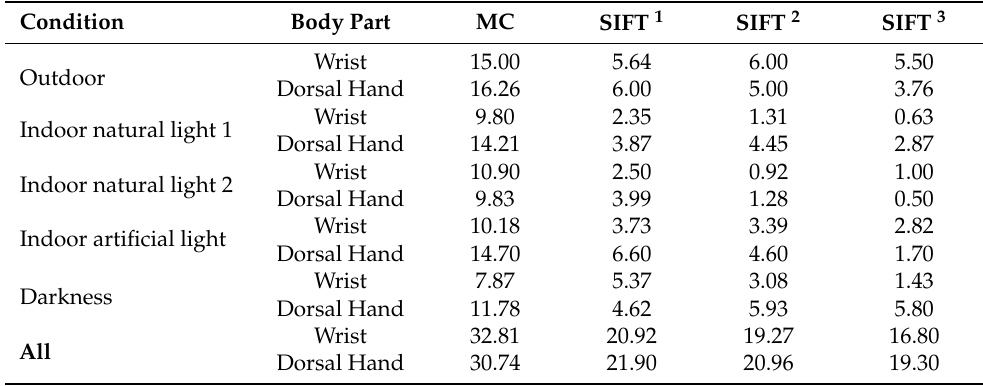
Table 1. EER values (%) obtained for the database acquired.